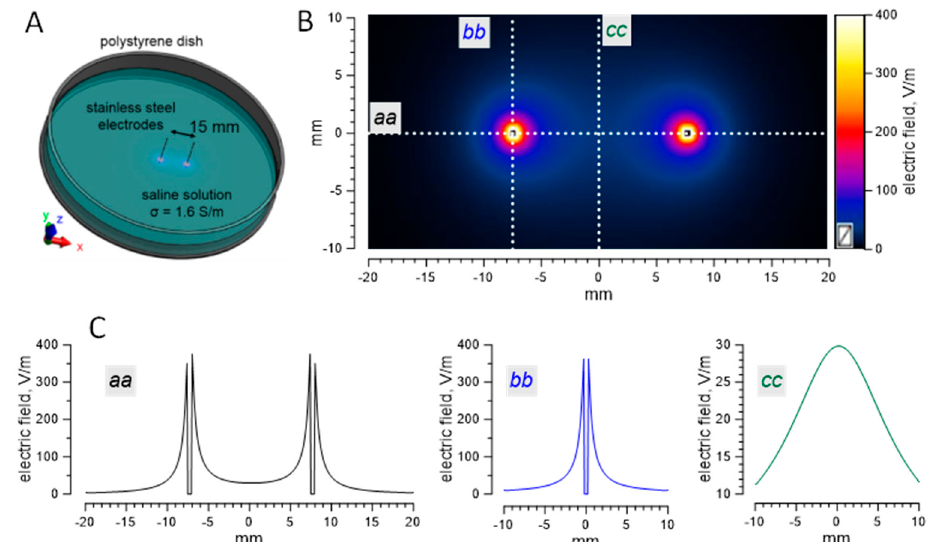
Figure 9. An example of electric field simulations. ( A ) A schematic of the setup used for simulations. ( B ) The electric field distribution in a plane parallel to the bottom of the dish at 2 mm below the saline surface. The values are for 1 V applied between the electrodes (bright spots on the aa line). The electric field values along the aa , bb , and cc lines are shown on the graphs in panel ( C ).